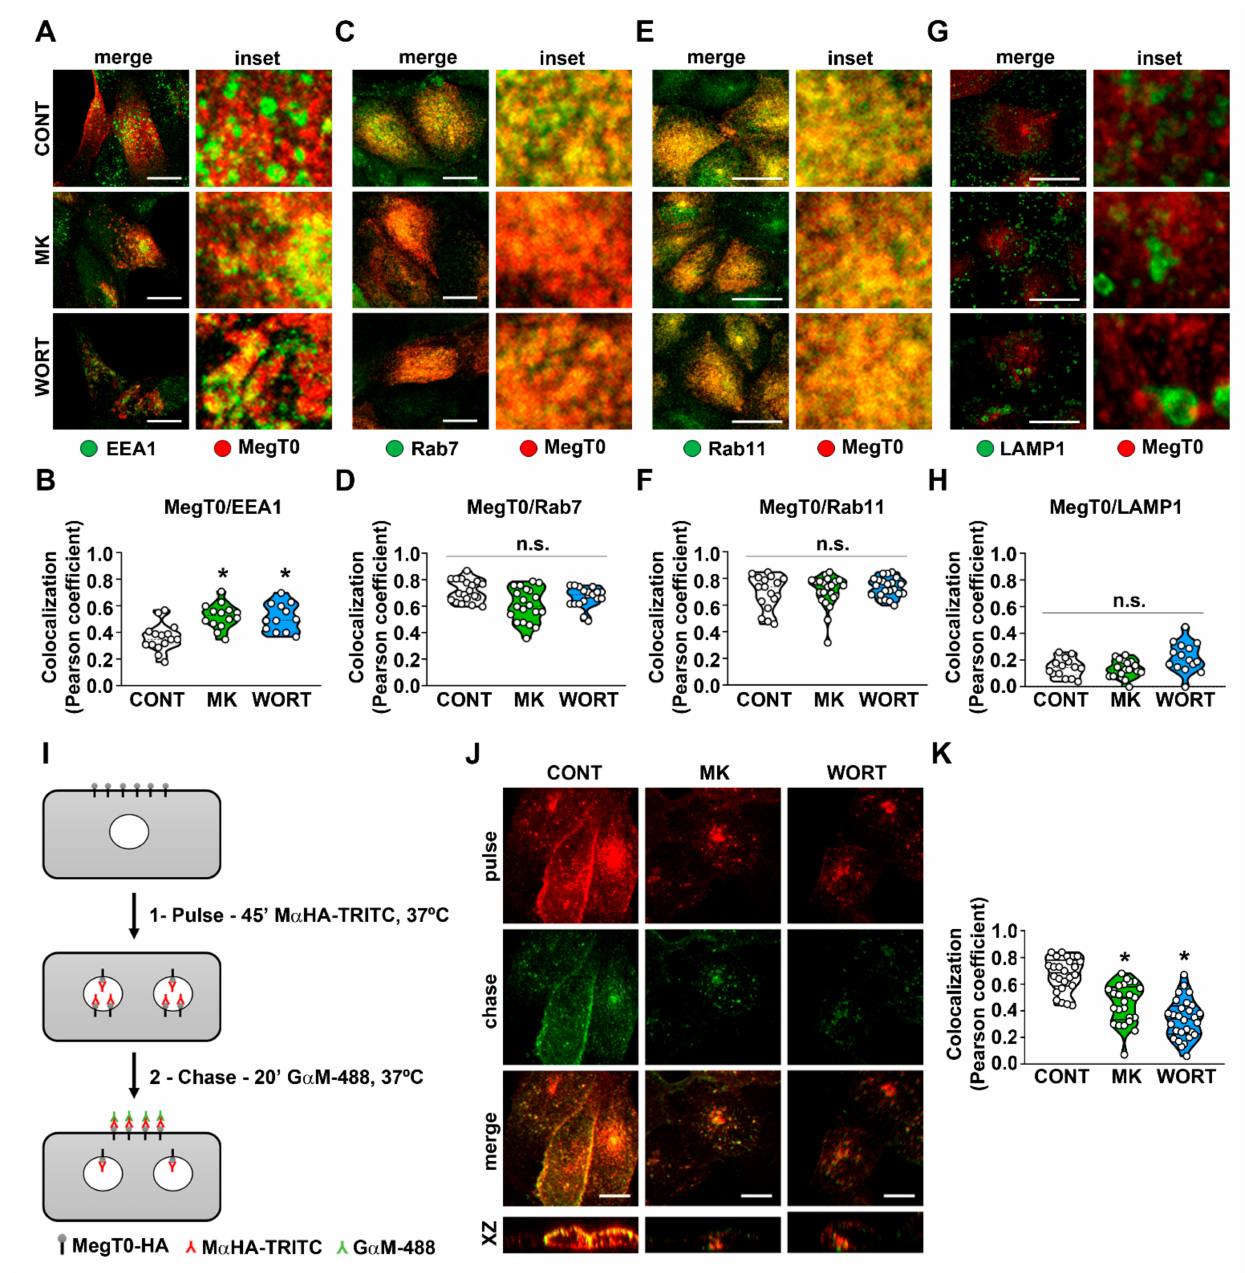
Figure 3. PI3K/AKT inhibition increases megalin presence in early endosomes and reduces megalin cell surface recycling. Representative confocal images showing colocalization of MegT0 and EEA1 (( A , B ) cell number: CONT = 15, MK = 14, WORT = 12; n = 3), scale bar = 20 µ m; Rab7 (( C , D ) cell number: CONT = 19, MK = 20, WORT = 19; n = 3), scale bar = 20 µ m; Rab11 (( E , F ) cell number: CONT = 17, MK = 22, WORT = 22; n = 3), scale bar = 20 µ m; and LAMP1 (( G , H ) cell number: CONT = 14, MK = 19, WORT = 15; n = 3), scale bar = 20 µ m, was accessed by immunofluorescence and quantified using Pearson’s coefficient. Results are presented as violin plots. Schematic representation of the pulse-chase approach used to detect MegT0 recycling ( I ). The detailed protocol is described in the Methods section. Representative confocal images of MegT0 recycling in LLC-PK1 cells treated for 1 h with MK or WORT, compared with control cells (CONT) (( J , K ) cell number: CONT = 26, MK = 25, WORT = 28; n = 3), scale bar = 10 µ m;. Data are presented as means ± standard deviation. * p < 0.05 versus control. One-way ANOVA with Tukey’s multiple comparisons test was used. n.s., no